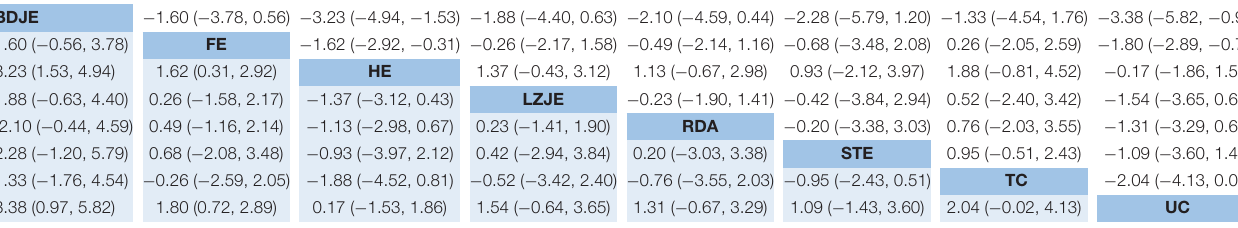
TABLE 2 | The consistency model of MMSE.